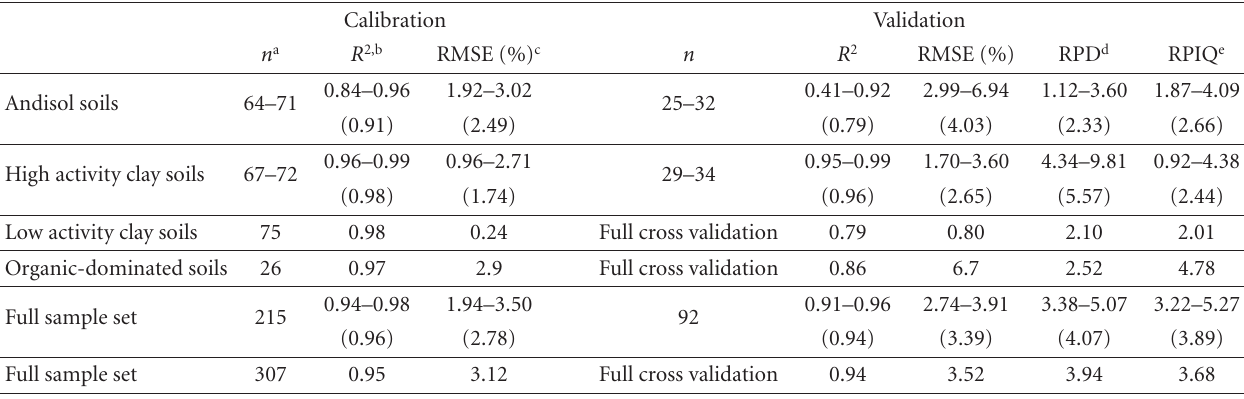
Table 5: Detailed partial least squares regression model results for soil total carbon (C t ) prediction from the subsets of mid-infrared di ff use reflectance spectra based on soil order. The range of values reflects the results of 10 random iterations of the models, and the number in parentheses is the mean. Detailed results are also given for full sample set models with no subsetting for comparison. For models with full cross validation (i.e., leave-one-out cross validation), the same samples used to calibrate the model were used to validate the